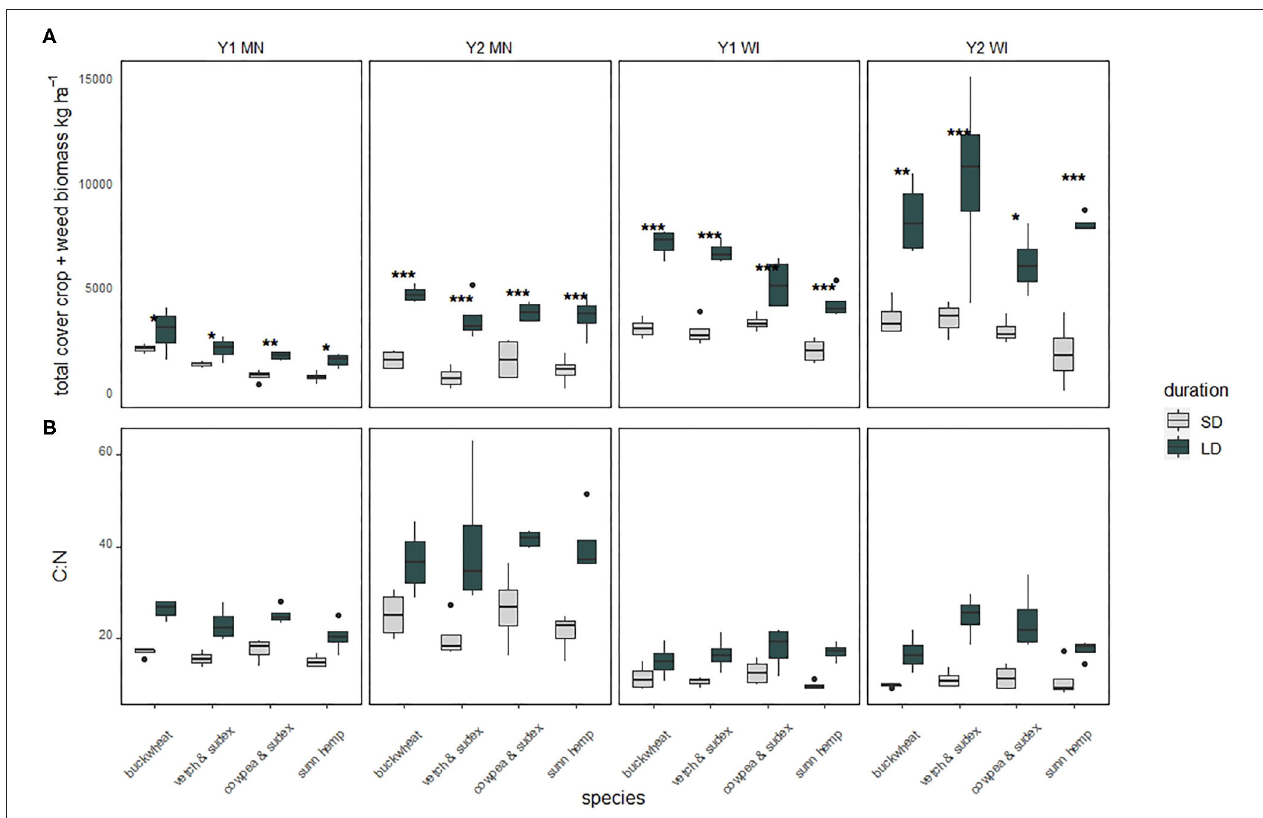
FIGURE 1 | Total biomass (A) and biomass C:N (B) from each site year divided by species, compared between durations. Short duration (SD) appear on the left of each pair (lighter shading), long duration (LD) on the right (darker shading). Significant differences between duration for a species are indicated by stars above the pair. * p < 0.05, ** p < 0.01, *** p <